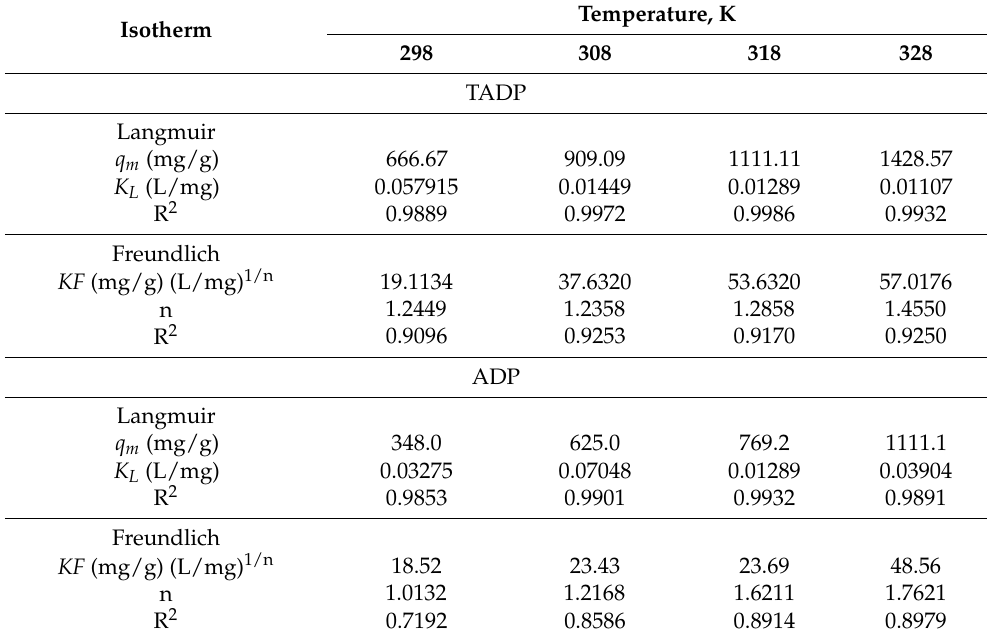
Table 2. Isotherm parameters for the adsorption of Cu(II) on ADP and TADP.